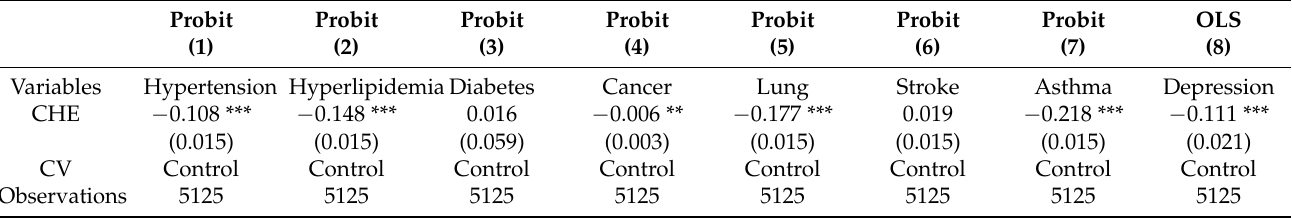
Table 8. The regression results of CHE and different